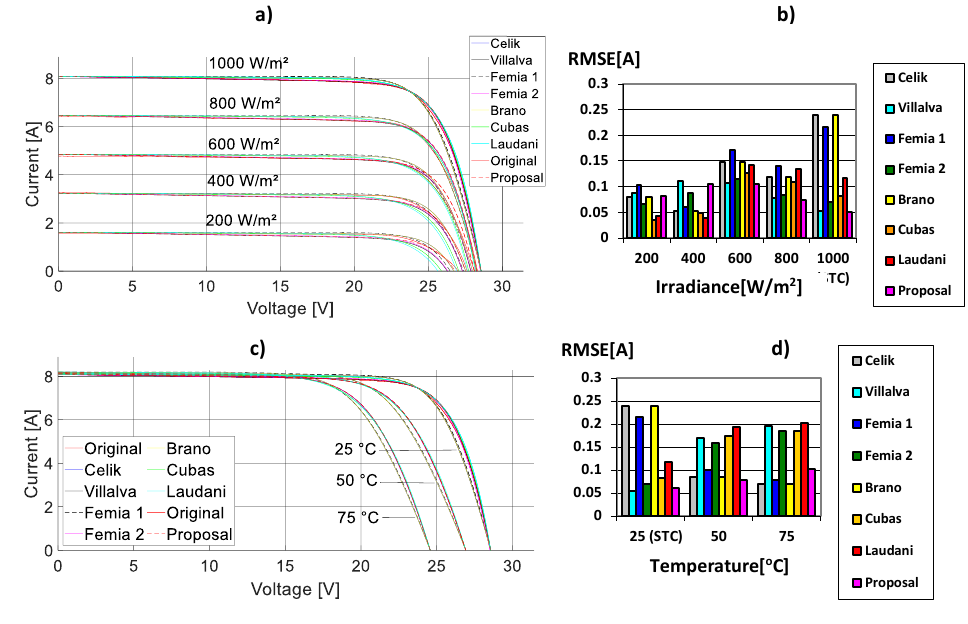
Figure 5. Comparison between calculated (eight models) and maker I-V curves of Kyocera KC175GHT-2: ( a ) at T = 25 ◦ C; ( b ) RMSE at T = 25 ◦ C; ( c ) at G = 1000 [W/m 2 ]; ( d ) RMSE at G = 1000 [W/m 2